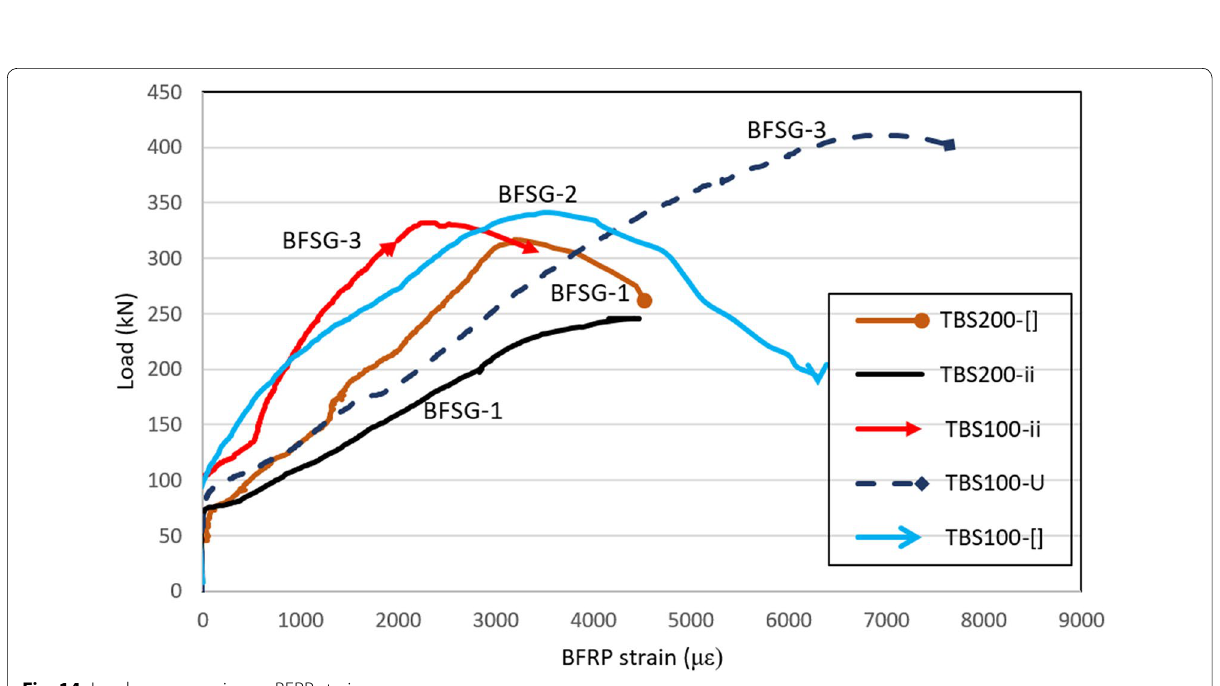
Fig. 14 Load versus maximum BFRP